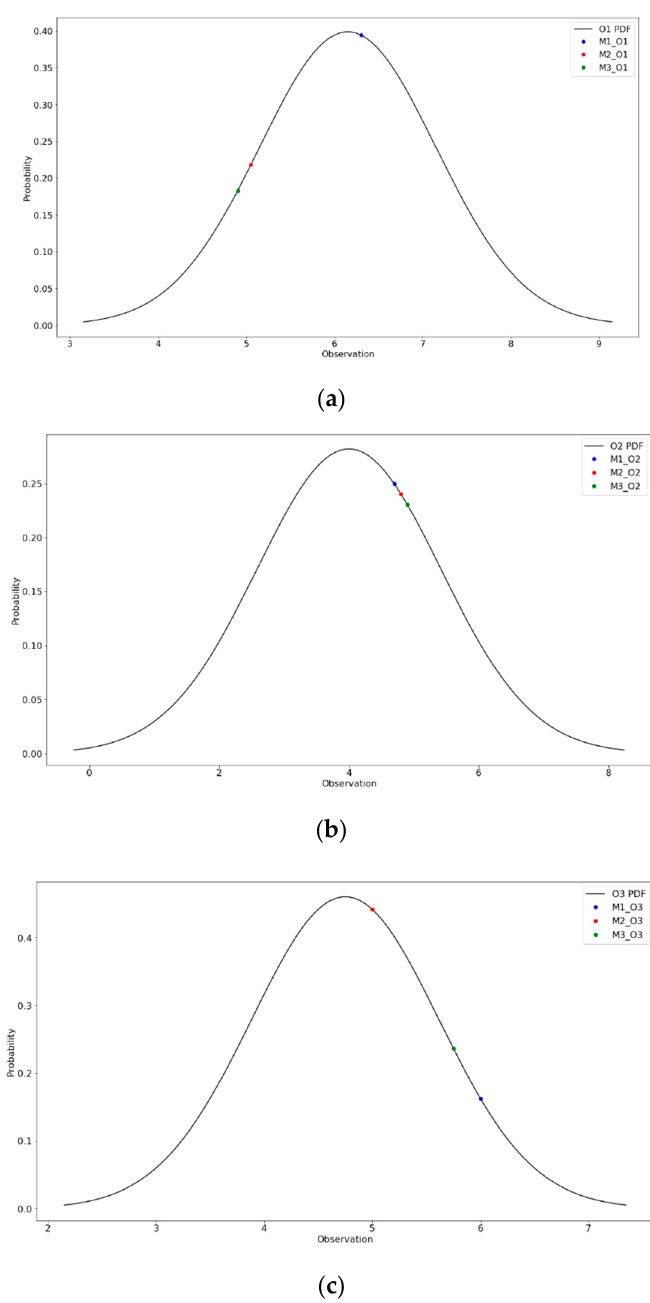
Figure 4. Probability distribution based on observed value and assumed variance with corresponding model-forecast observations for three proposed observations: ( a ) O1; ( b ) O2; and ( c ) O3.